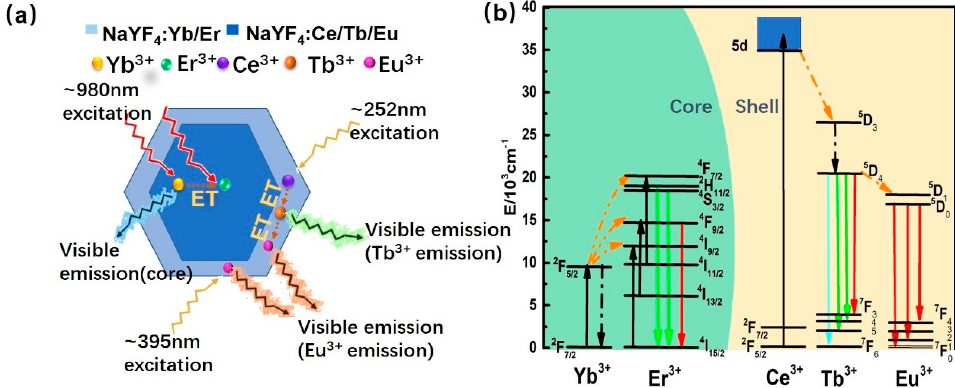
Figure 7. ( a ) Schematic illustration of NaYF 4 :Yb/Er@NaYF 4 :Ce/Tb/Eu core-shell microcrystals to achieve the dual-mode emission. ( b ) Proposed schematic diagram of the energy transfer processes for dual-mode emission in the core-shell microrods.